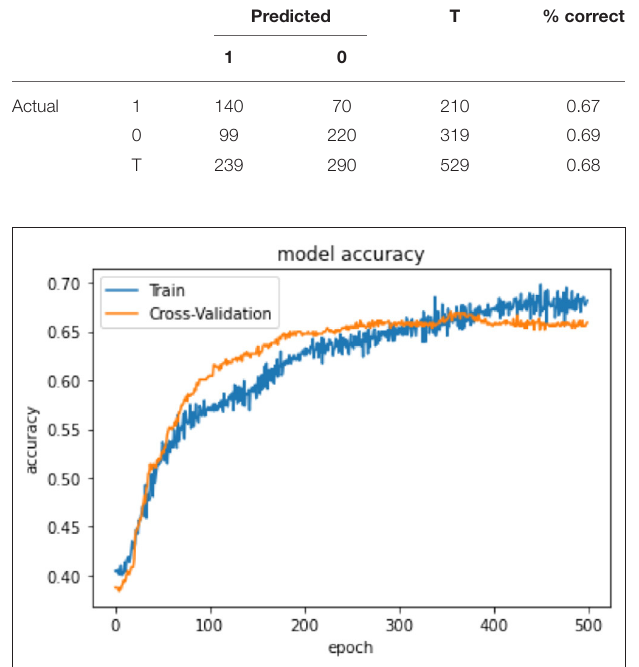
FIGURE 6 | ANN model accuracy pooled set.